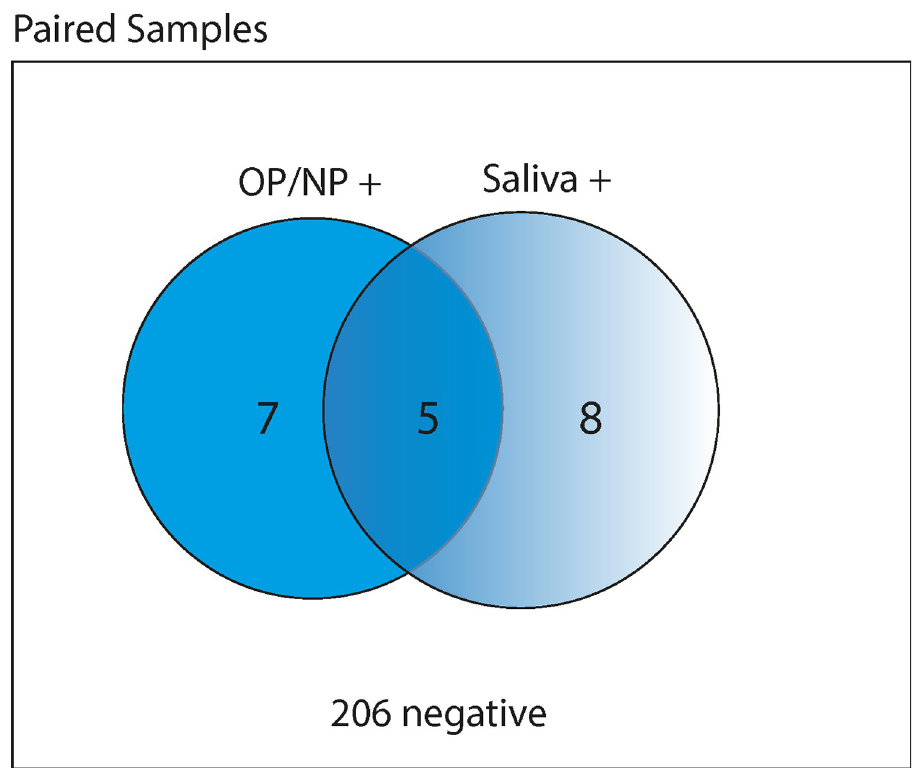
Fig 3. Paired analysis of SARS-CoV-2 RNA in oropharyngeal/nasopharyngeal (OP/NP) and saliva samples. Venn diagram indicating SARS-CoV-2 RNA status of saliva and OP/NP samples that were paired (samples collected by a participant on the same day), by RT-PCR. Numbers indicate pairs of